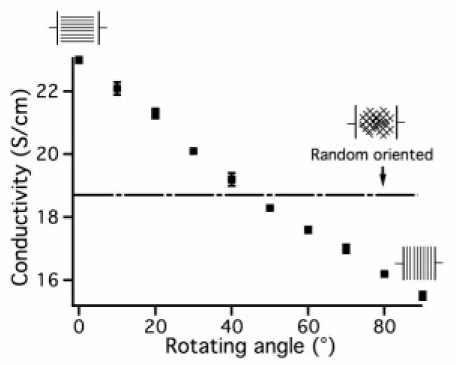
Figure 6. Conductivity of aligned mesoporous carbon films as a function of the orientation of the electrodes to the alignment direction of the cylindrical mesoporous